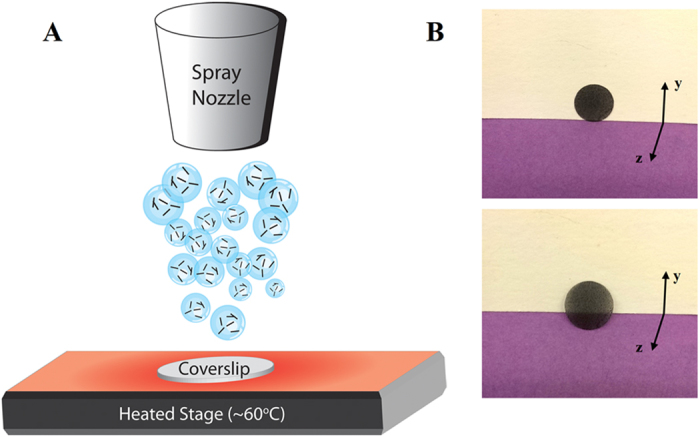
Fabrication of crosslinked carbon nanomaterial films. (A) Illustration of in situ crosslinking process. (B) Photograph of film standing vertically (top) and tilted to show transparency (bottom).